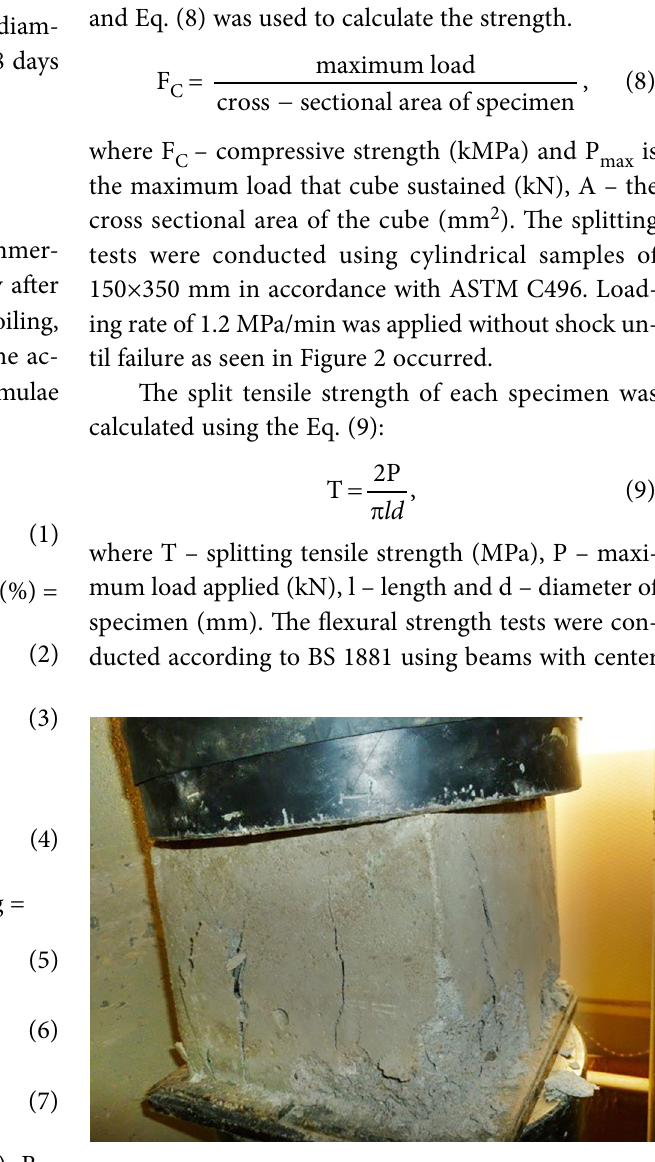
Fig. 1. Failure of